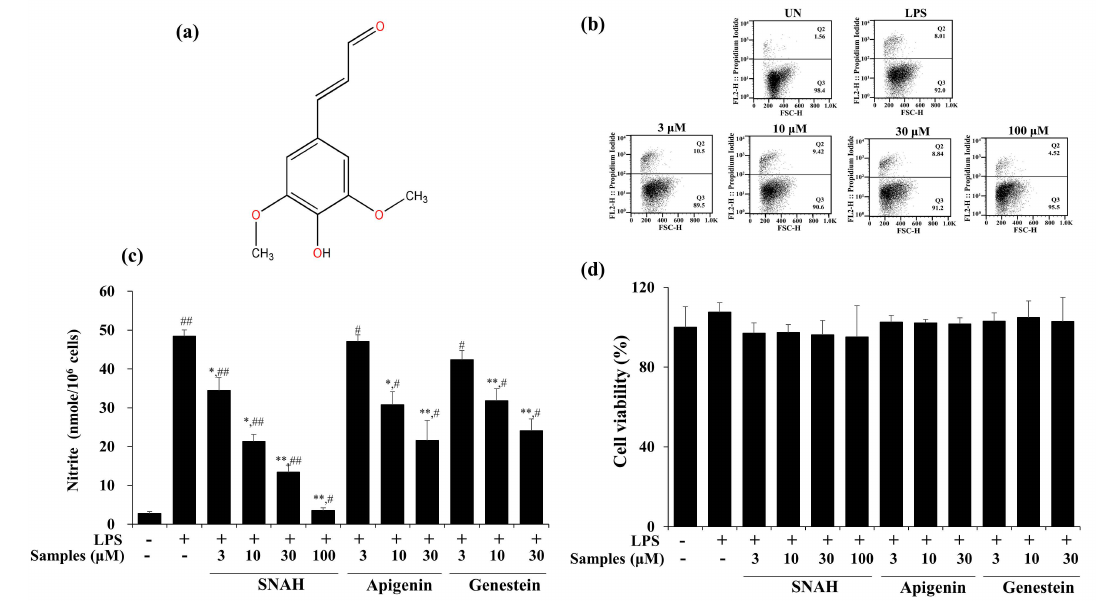
Figure 1. Effects of SNAH (sinapaldehyde) on cell viability and LPS (lipopolysaccharide)-induced NO (nitric oxide) production in RAW 264.7 cells. ( a ) The chemical structure of SNAH. ( b ) The viability of Raw264.7 cells was determined by FACS (fluorescence activated cell sorter) analysis. ( c ) Cells were pretreated with 3, 10, 30, and 100 μ M SNAH for 1 h before treatment with 1 μ g/mL LPS. After incubation for 18 h, NO production was detected by Griess test. ( d ) The cell viability was detected by XTT assay. The values are presented as means ± SD of three independent experiments. * p < 0.05, ** p < 0.01, compared to the LPS-treated group. # p < 0.05, ## p < 0.01, compared to the LPS non-treated group.